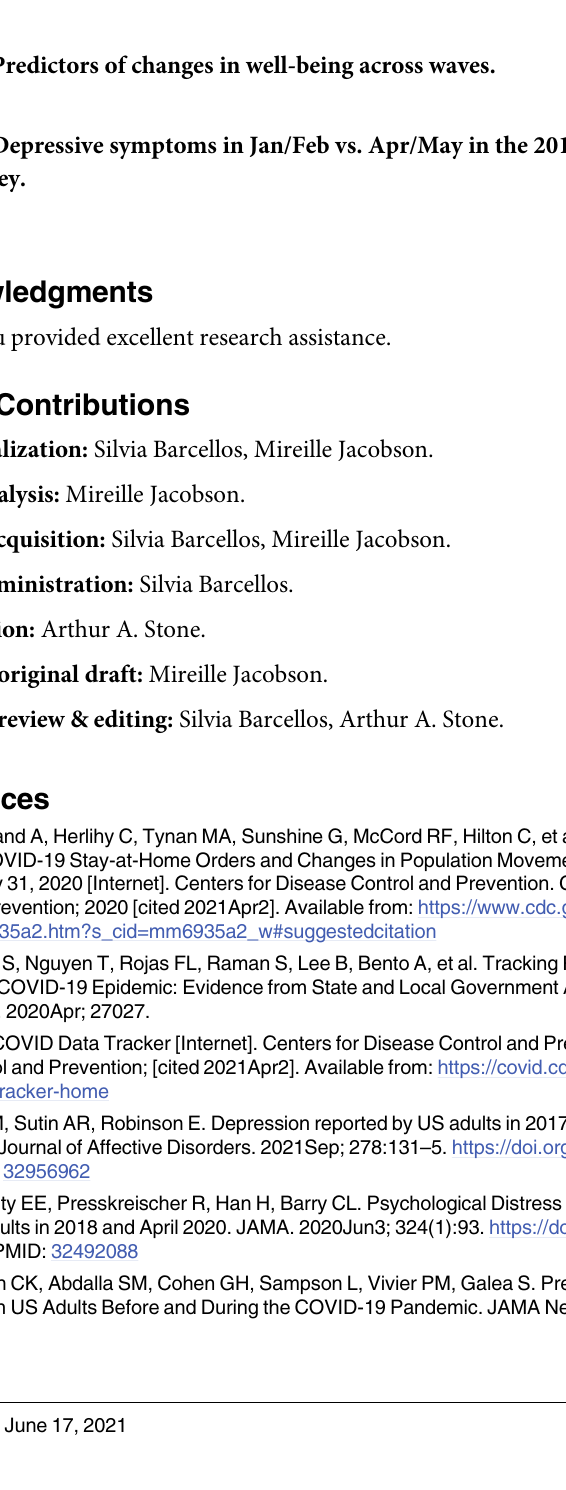
S1 Table. Predictors of only wave 1 participation. S2 Table. Changes in well-being across waves by demographic characteristics. S3 Table. Predictors of the Z-score of changes in well-being across waves. S4 Table. Predictors of changes in well-being across waves. S5 Table. Depressive symptoms in Jan/Feb vs. Apr/May in the 2018 medical expenditure panel